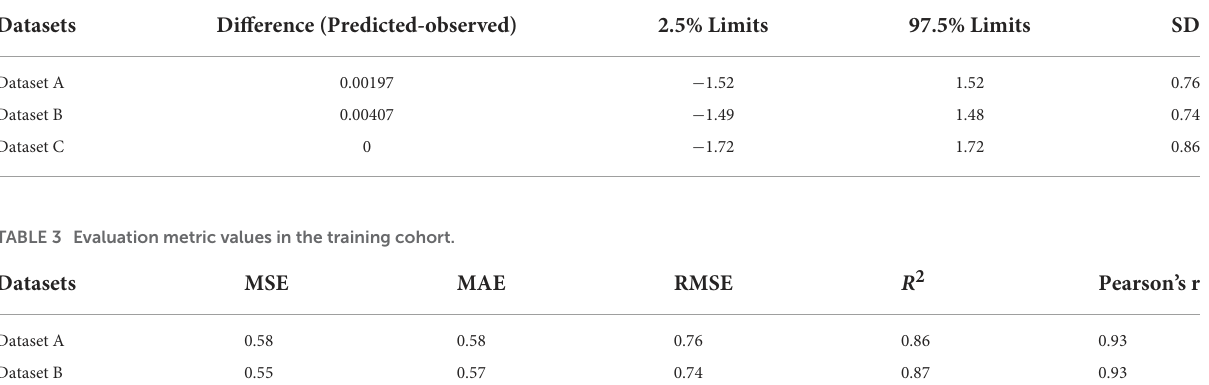
TABLE 2 95% agreement limits of estimated LSM for three datasets in the training cohort.